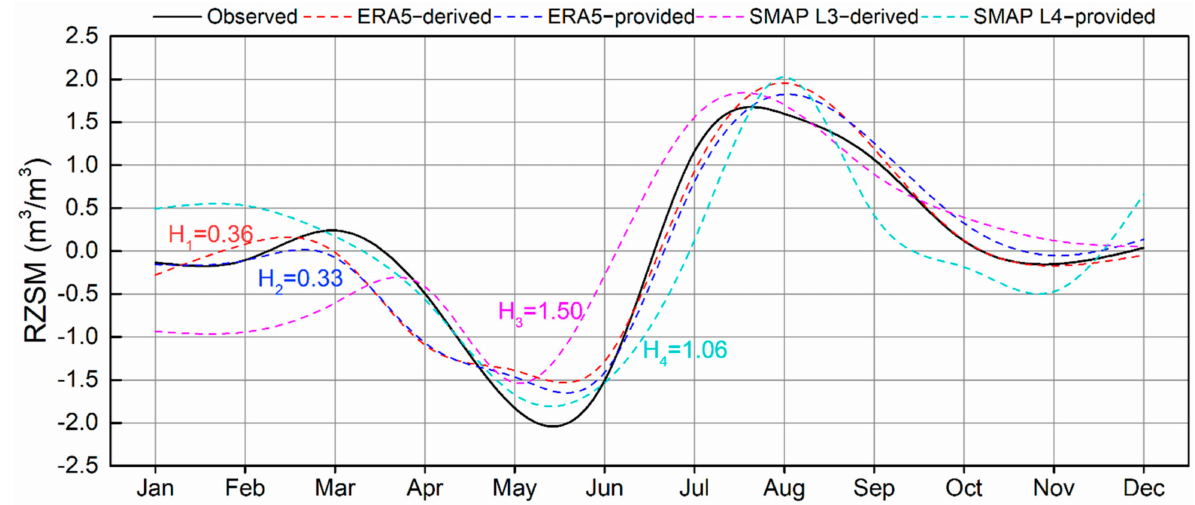
Figure 11. Seasonality of soil moisture distribution among different RZSMs estimated from multi- source SM datasets. (Herein H 1 , H 2 , H 3 , and H 4 indicates the Hausdorff distance of ERA5-derived, ERA5-provided, SMAP L3-dervived, and SMAP L4-provided RZSM against the observed RZSM trajectories, respectively, and note that all data series were standardized using the Z-score